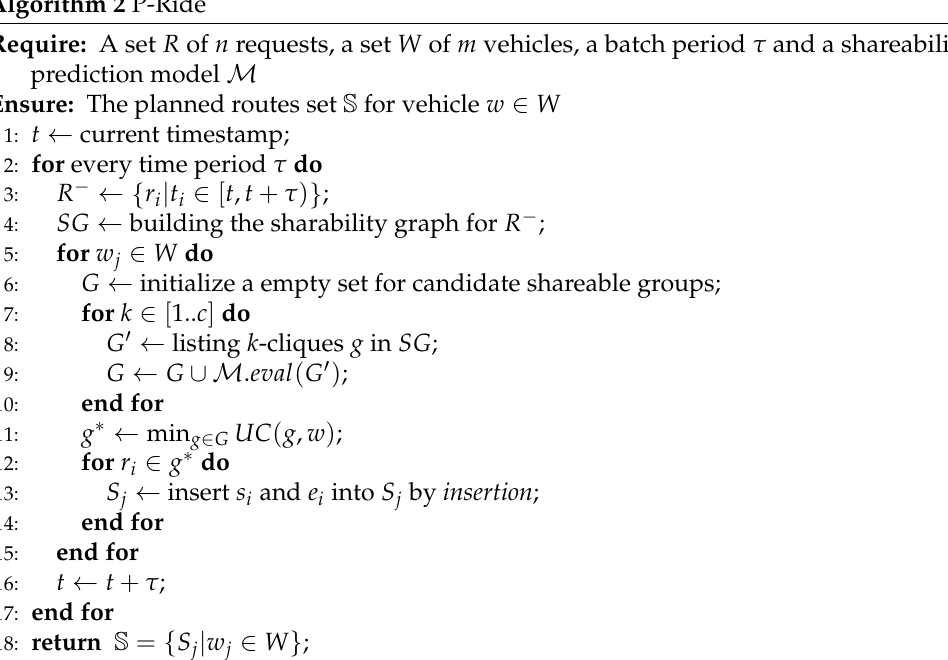
Algorithm 2 P-Ride